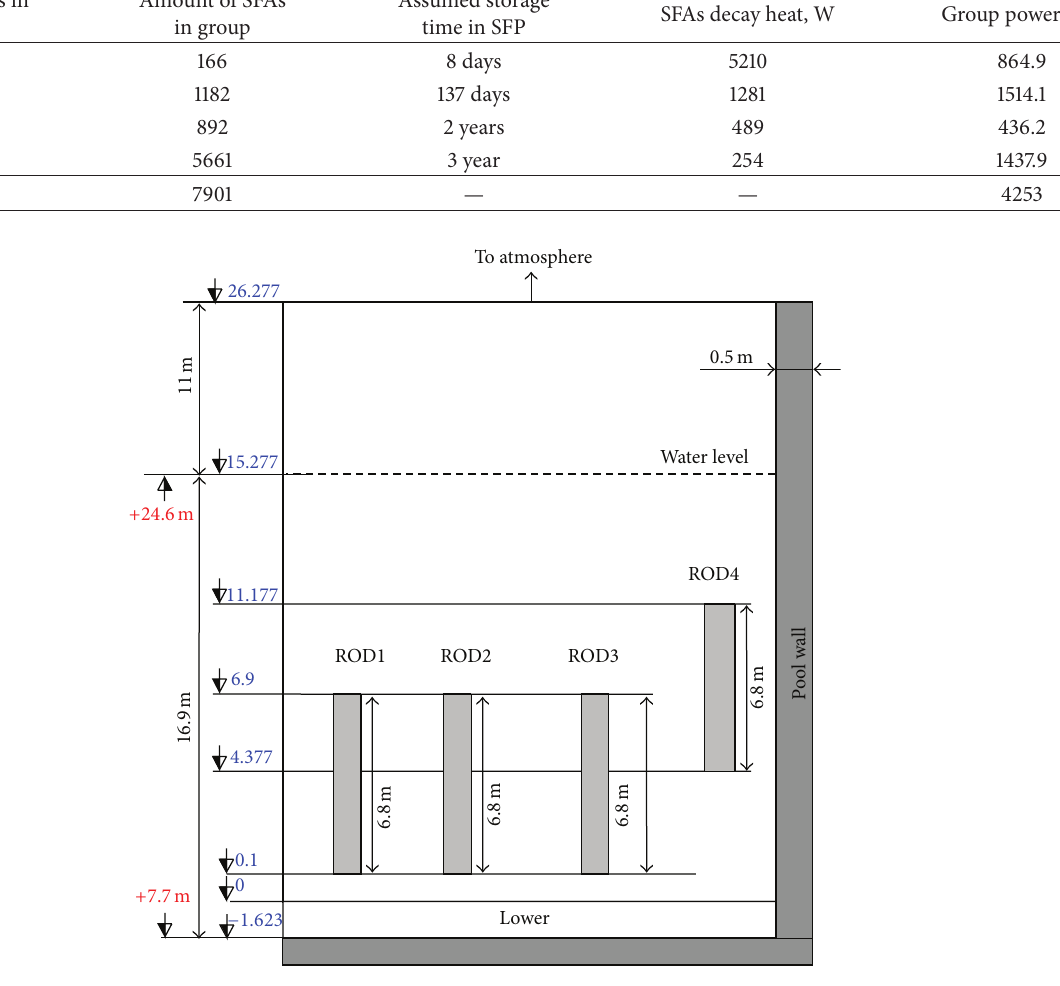
Figure 2: SFP and SFAs nodalization scheme in ASTEC